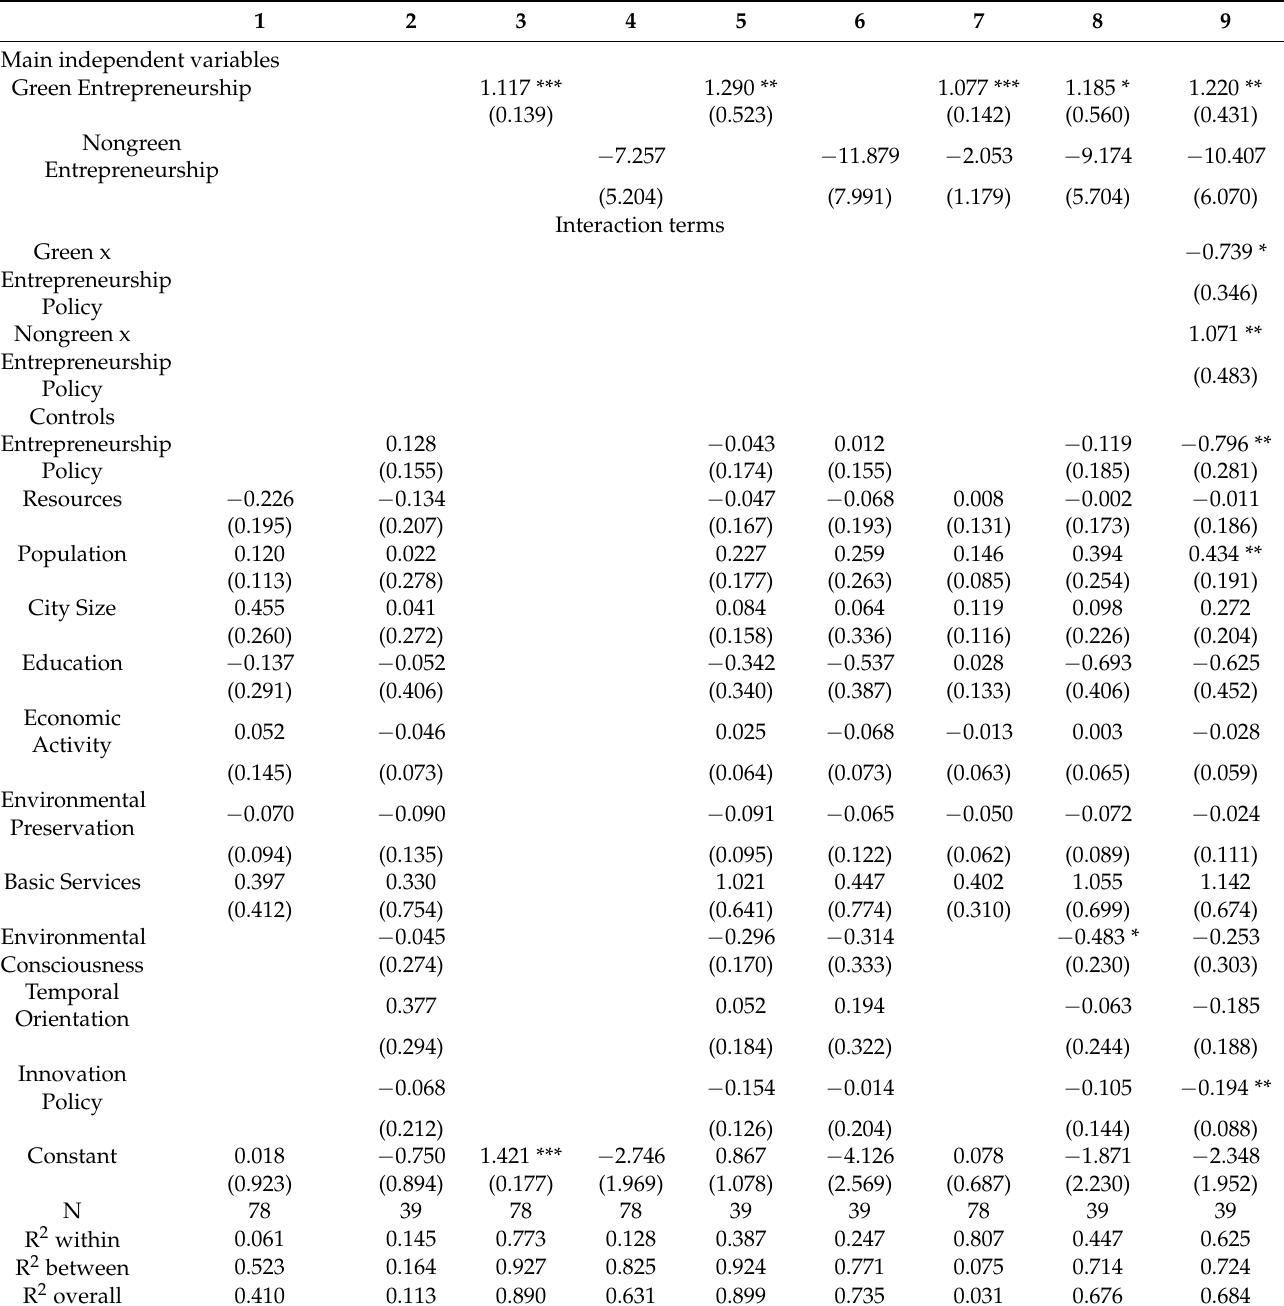
Table A4. Regression analysis (DV = economic